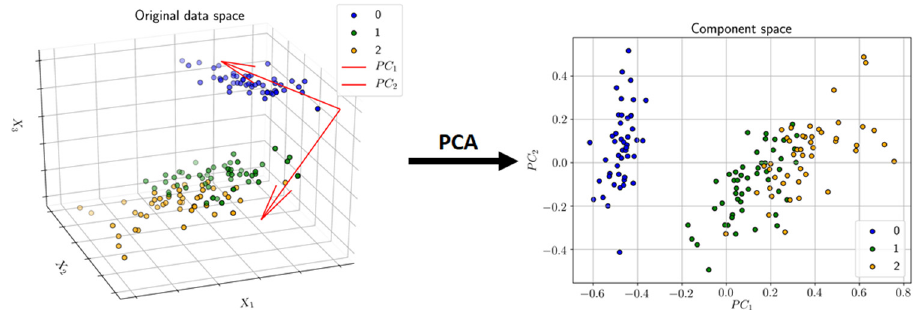
Figure 7. An example of dimensionality reduction by means of PCA. Instances/points in a 3D space (original space) are transformed into a 2D space of two latent variables called principal components (PC1 and PC2).